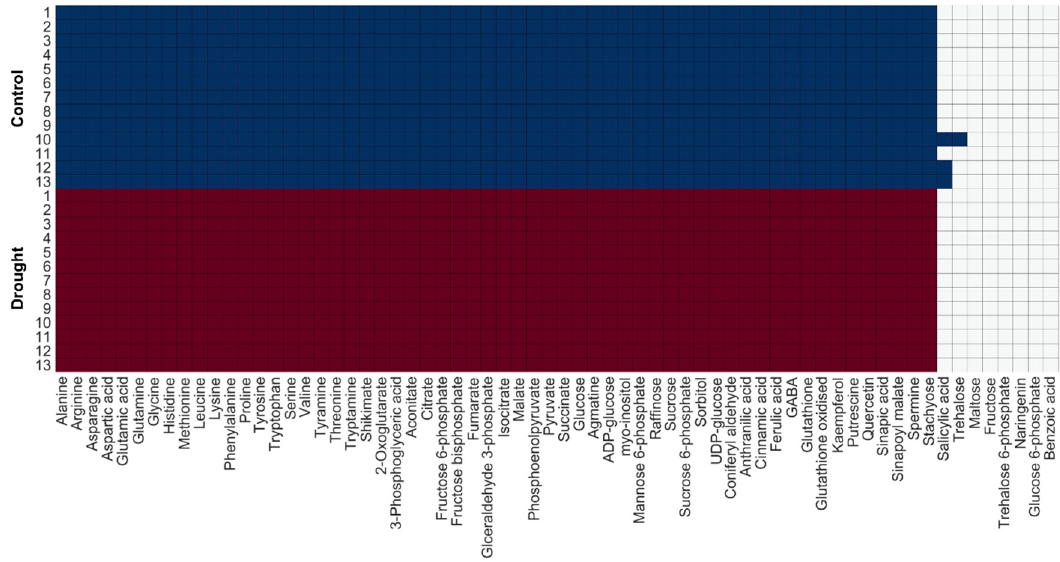
Figure 3. The list of 66 metabolites indicating occurrence percentage of each GEM: Blue and red represent metabolites present in control and drought GEMs, respectively.